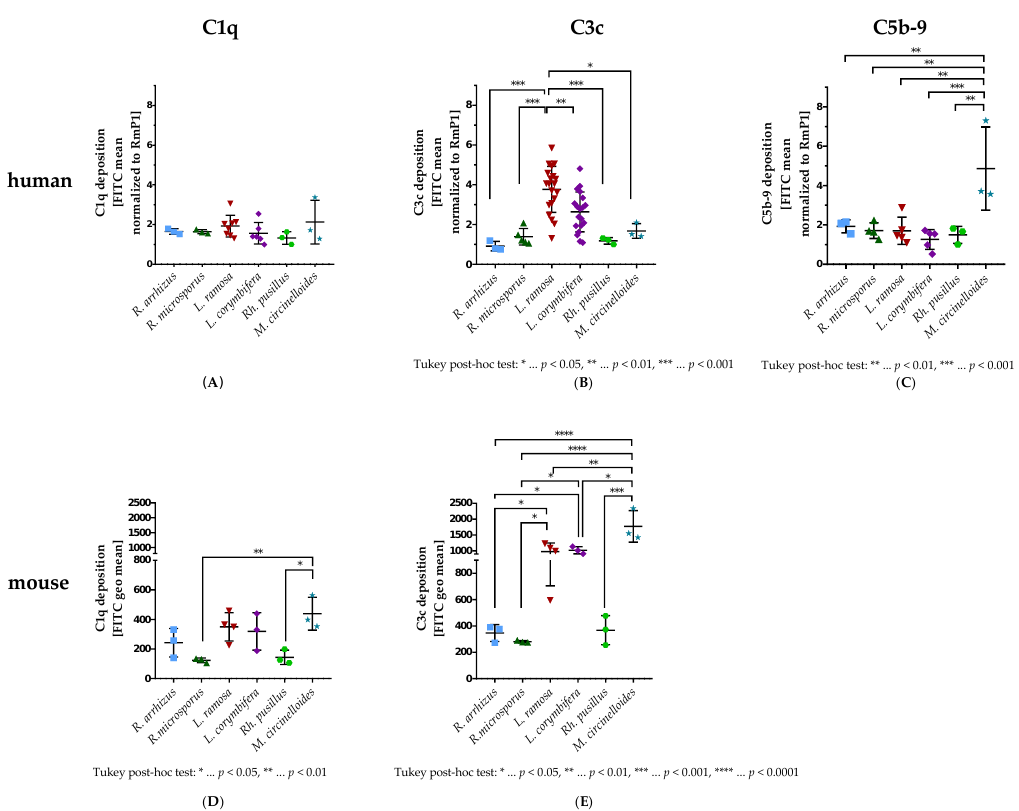
Figure 1. C1q, C3c, and C5b-9 deposition on the spore surface of different strains of R. arrhizus , R. microsporus , L. ramosa , L. corymbifera , Rh. pusillus , and M. circinelloides . Spores were opsonized with 60% of either normal human serum (NHS) ( A – C ) or normal mouse serum (NMS) ( D , E ) for either 60 min (C1q and C3c) or 90 min (C5b-9) at 37 °C in separate tubes. Specific anti C1q, C3c, or C5b-9 antibodies were used, and the deposition was measured using fluorescence-activated cell sampler (FACS) Verse with BD software. The deposition of human ( A ) and murine ( D ) C1q, human ( B ) and murine ( E ) C3c, and human C5b-9 ( C ) is shown as fluorescein isothiocyanate (FITC) mean normalized to a Rh. pusillus isolate (RmP1) ( A – C ) or FITC geometric mean (geo mean) ( D,E ). The results shown were gained by a minimum of two independently performed experiments, and at least three different strains per species were tested (mean ± SD). Asterisks (*) indicate the level of significance for an adjusted p -value, comparing pairs of groups using a Tukey post hoc test after the one-way ANOVA reported significance.